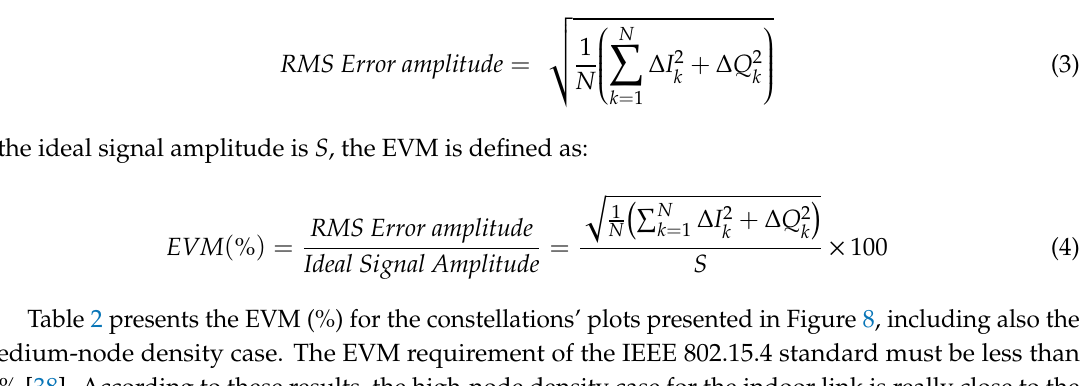
Sensors 2019 , 19 , 3516